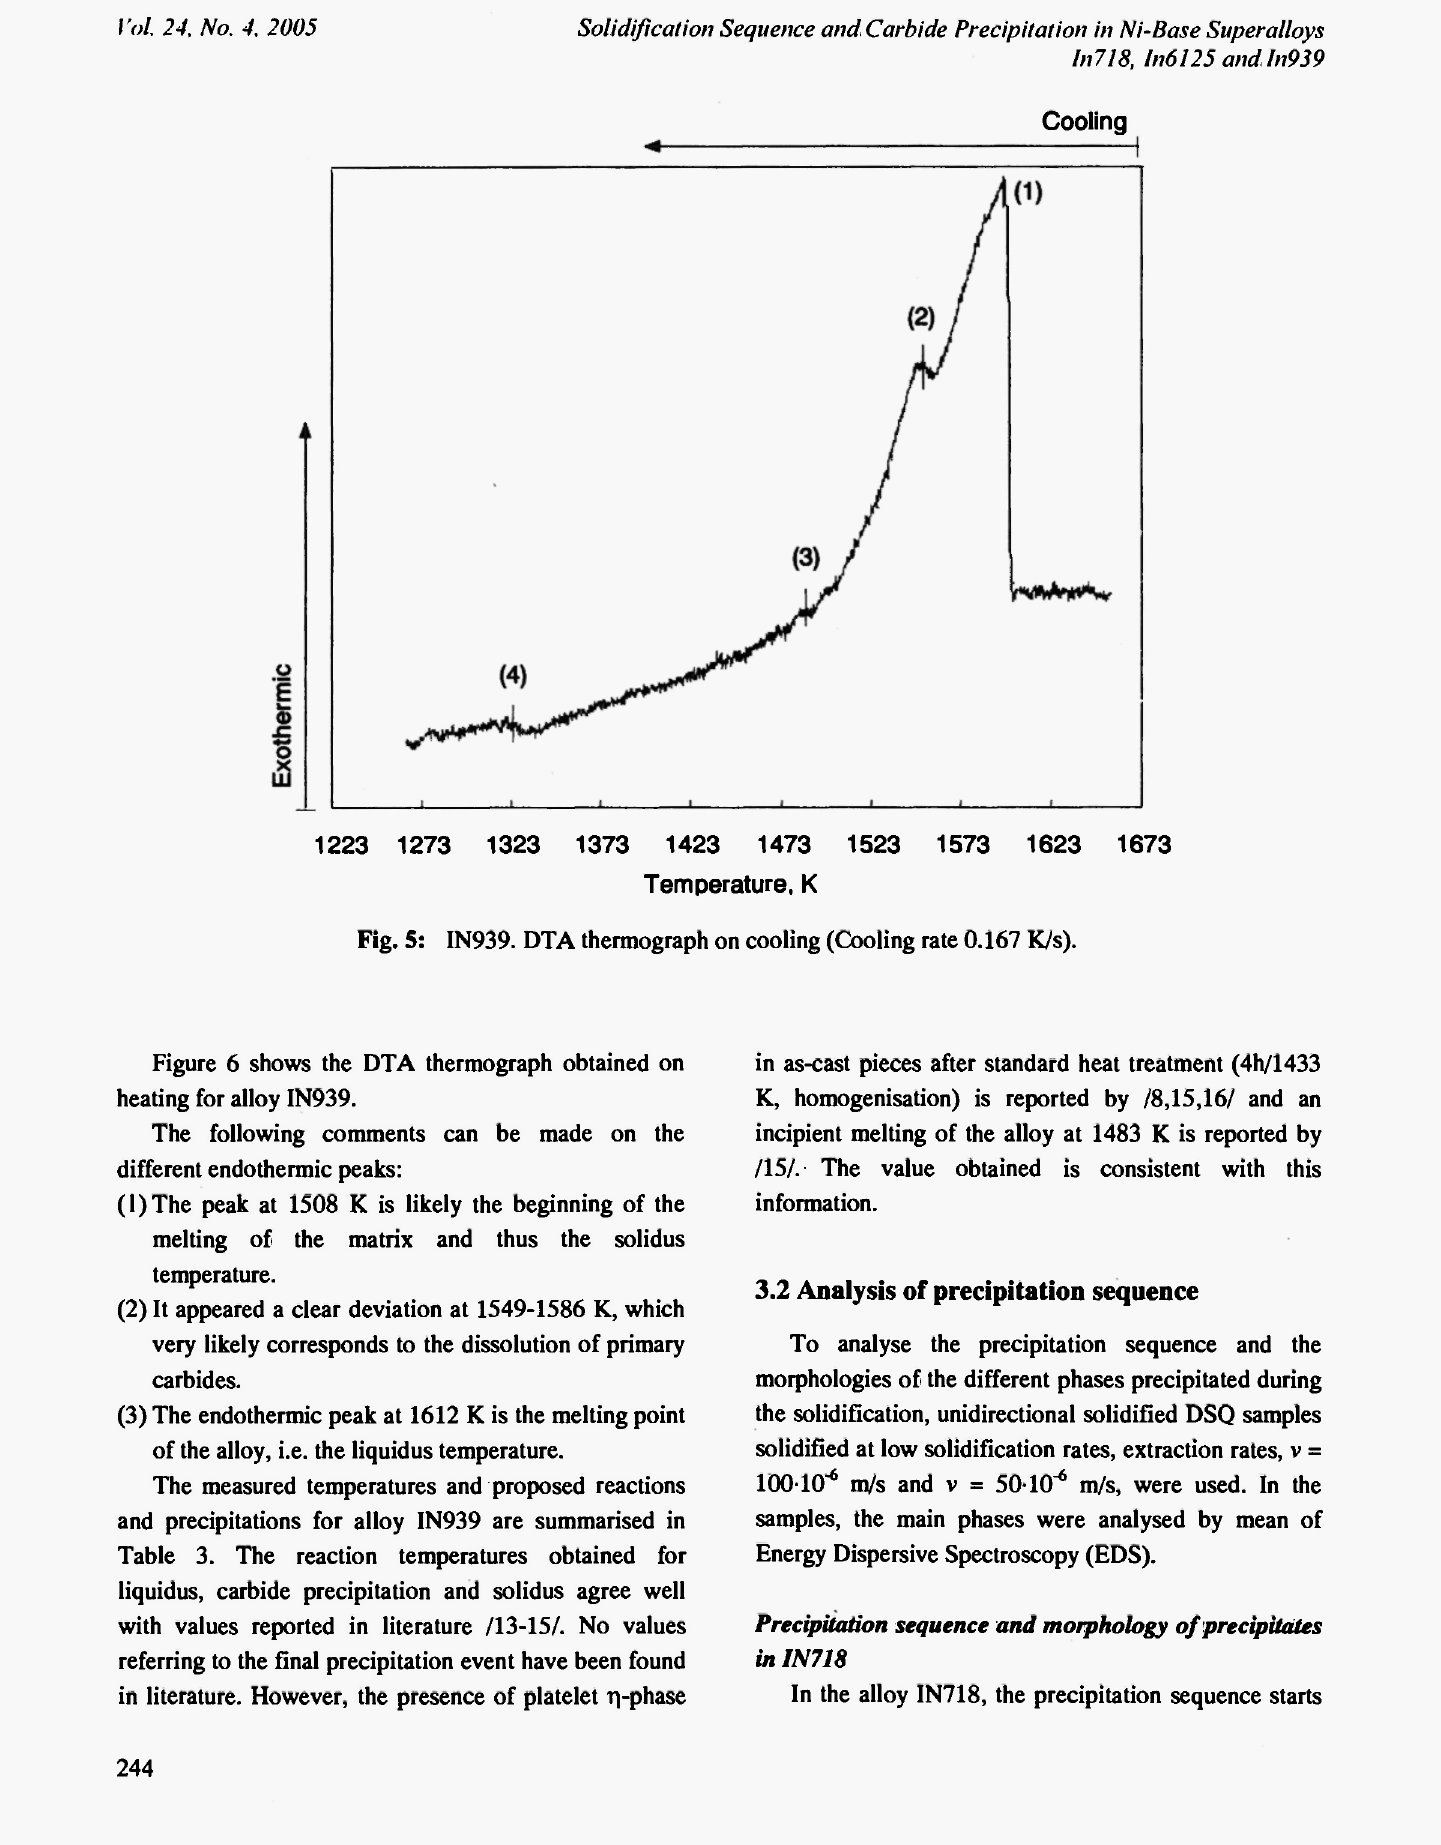
Fig. 5: IN939. DTA thermograph on cooling (Cooling rate 0.167